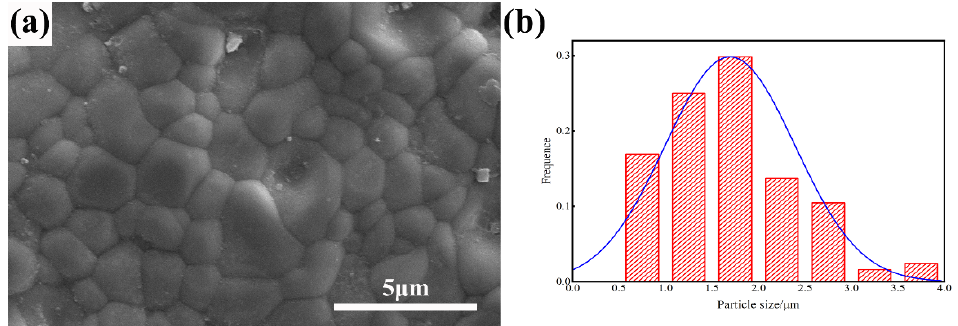
7 of 10 Figure 6. Photograph ( a ), and in-line transmittances curves ( b ) of the mirror–polished (Tb 0.7 Lu 0.3 ) 2 O 3 ceramics sintered at 1550 °C followed by HIP at 1575 °C. (Zirconia content from left to right is 0 at%, 2 at%, 3 at%, 4 at% and 5 at%).